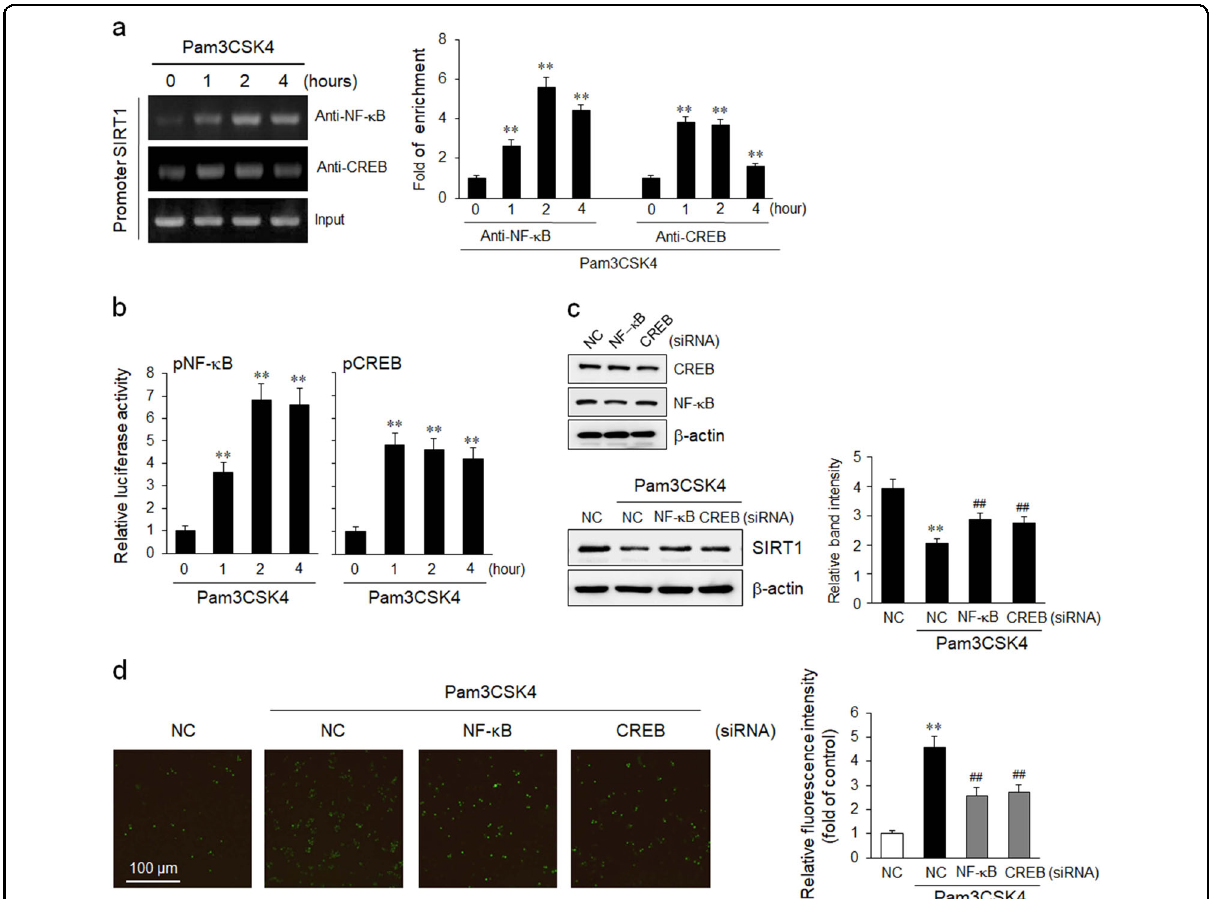
Fig. 6 Involvement of NF- κ B and CREB in the TLR2-mediated inhibition of SIRT1 transcription in monocytes. a The binding of NF- κ B and CREB to the SIRT1 promoter was detected using a ChIP assay. NF- κ B/DNA and CREB/DNA immune complexes were obtained from THP-1 cells stimulated with Pam3CSK4 for the indicated times. Speci fi c DNA fragments were quanti fi ed by PCR, as detailed in the Material and methods section. DNA puri fi ed from the lysates of cells incubated without an antibody was used as the input control (Input). Quantitative data are presented as the means ± SEM of six independent experiments. **P < 0.01 compared with the value at time 0. b THP-1 cells were transfected with luciferase reporter constructs containing NF- κ B and CREB consensus-binding sites and then stimulated with 100 ng/mL of Pam3CSK4 for the indicated times. The quantitation of NF- κ B and CREB activities is presented as the means ± SEM of six independent experiments. ** P < 0.01 compared with the value at time 0. c , d THP-1 cells were transfected with NF- κ B and CREB siRNAs, and then stimulated with 100 ng/mL Pam3CSK4 for 24 h. SIRT1 expression and cell adhesion to HUVECs were determined. Quantitative data are presented as the means ± SEM of 5 – 6 independent experiments. **P < 0.01 compared with the negative control (NC); ## P < 0.01 compared with the NC in the Pam3CSK4